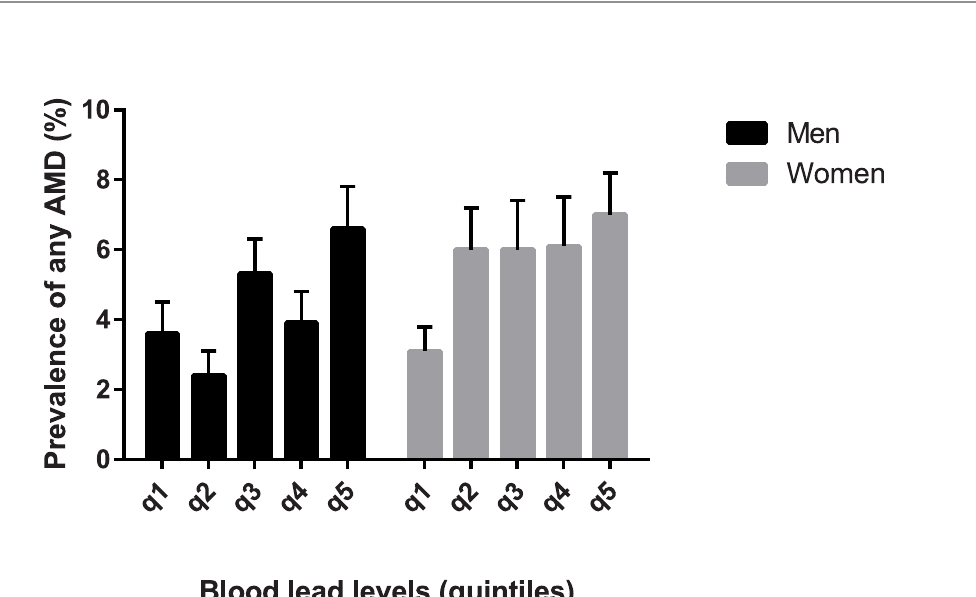
Fig 2. The prevalence of any AMD by quintile of blood lead level, stratified by gender.